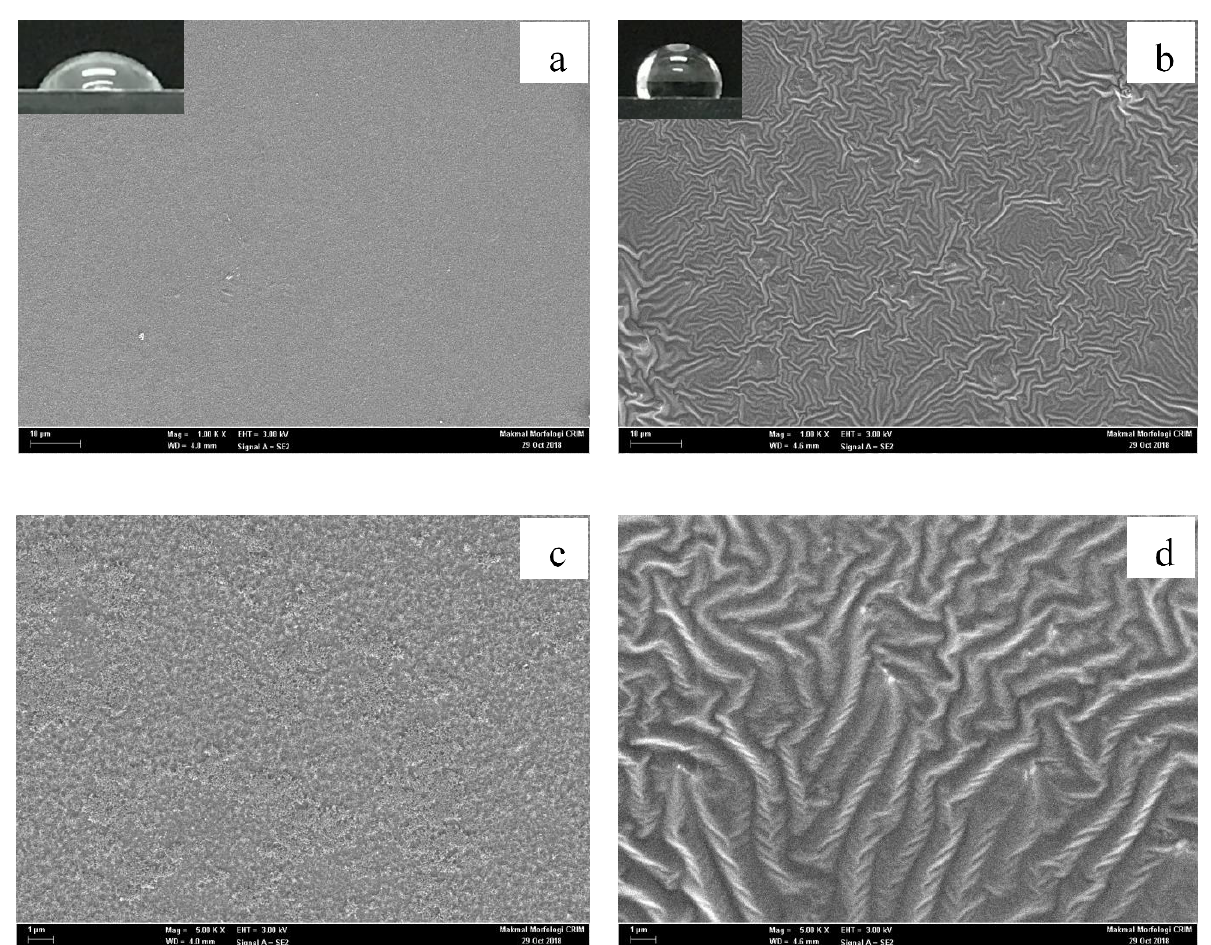
Figure 5. Surface morphology of the borosilicate glass under ( a , c ) untreated conditions and ( b , d ) PDMS-treated conditions at different magnifications: ( a , b ) at 1000 × magnification and ( c , d ) at 5000 × magnification.